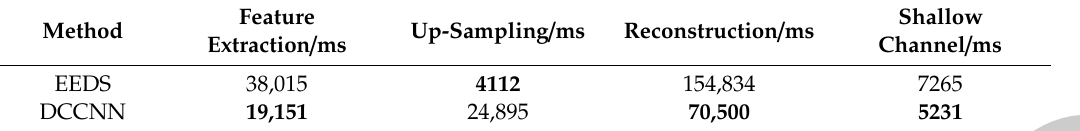
Table 2. Comparison of computational complexity with